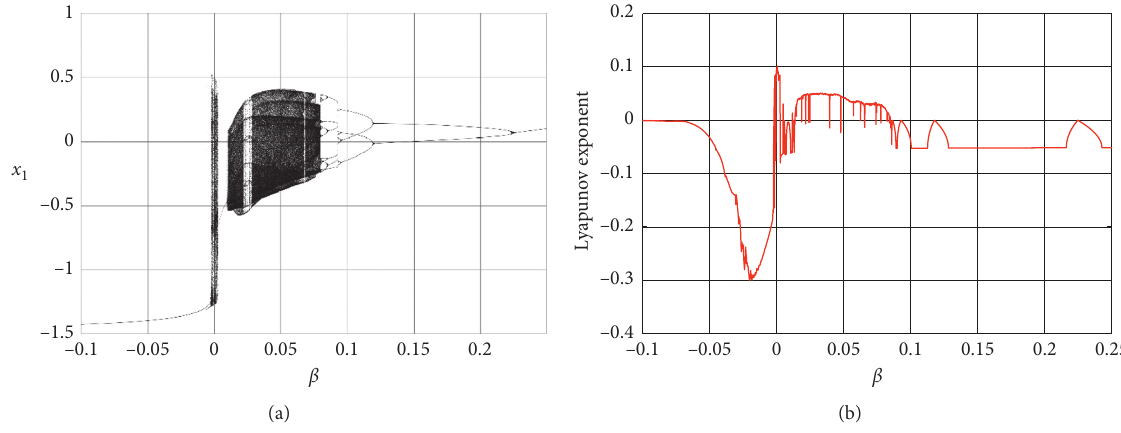
Figure 3: (a) Bifurcation diagram and (b) Lyapunov exponent with r � 0.1, a � 1.6, b � 0.05, c � 0.35, d � 4 / 27, e � 0.0001, Γ � 0.2, p � 0.009, Ω � 1.0, and β ∈ [ − 0.1: